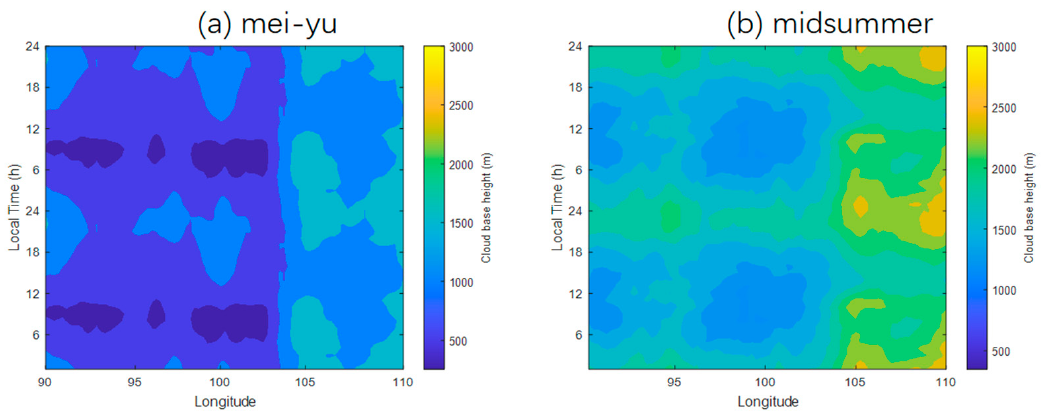
Figure 7. Diurnal variation in cloud base height from ERA5 over the Tibetan Plateau and Sichuan Basin during the ( a ) mei-yu and ( b ) midsummer periods.